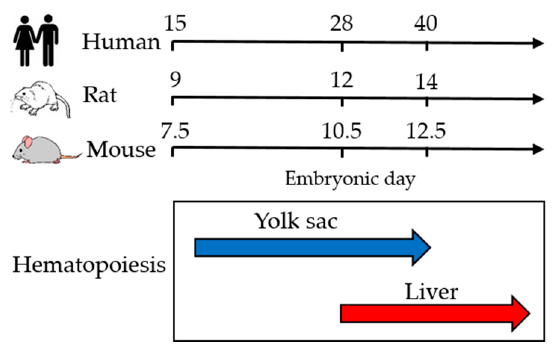
Figure 2. Phases of hematopoiesis in experimental rodents and humans during embryogenesis.